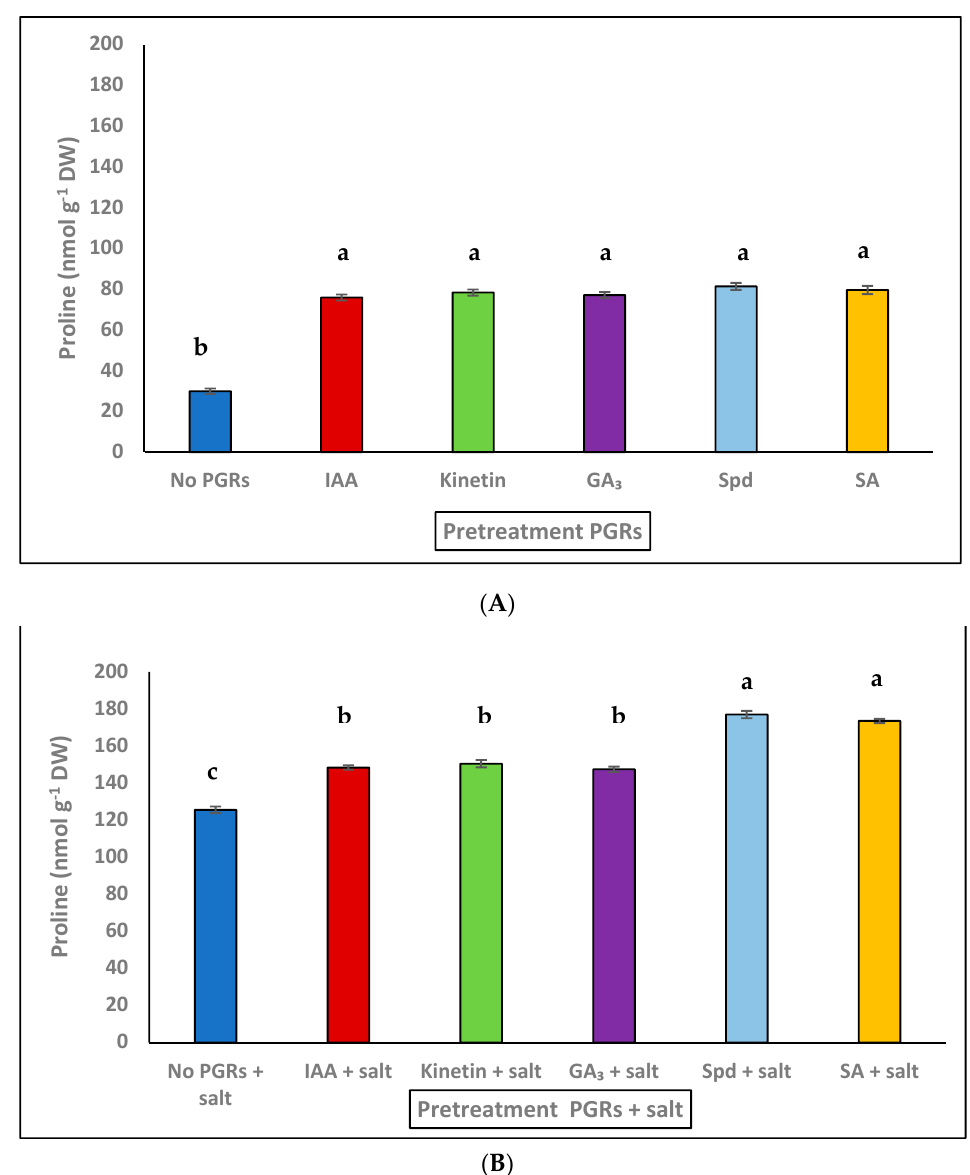
Figure 2. ( A ) Proline content in F. pulverulenta leaves cultivated with pretreatment PGRs: IAA, Kinetin, GA 3 , Spd, and SA respect to control (no PGRs). ( B ) Proline content cultivated with PGRs + salt: IAA + NaCl, Kinetin + NaCl, GA 3 + NaCl, Spd + NaCl and SA + NaCl, respect to control only with salt (NaCl 300 mM). Values represent means ± SE ( n = 4). Different letters above bars represent significant differences between treatments ( p ≤ 0.01).